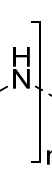
Figure 6. Schematic structure of polylysine.